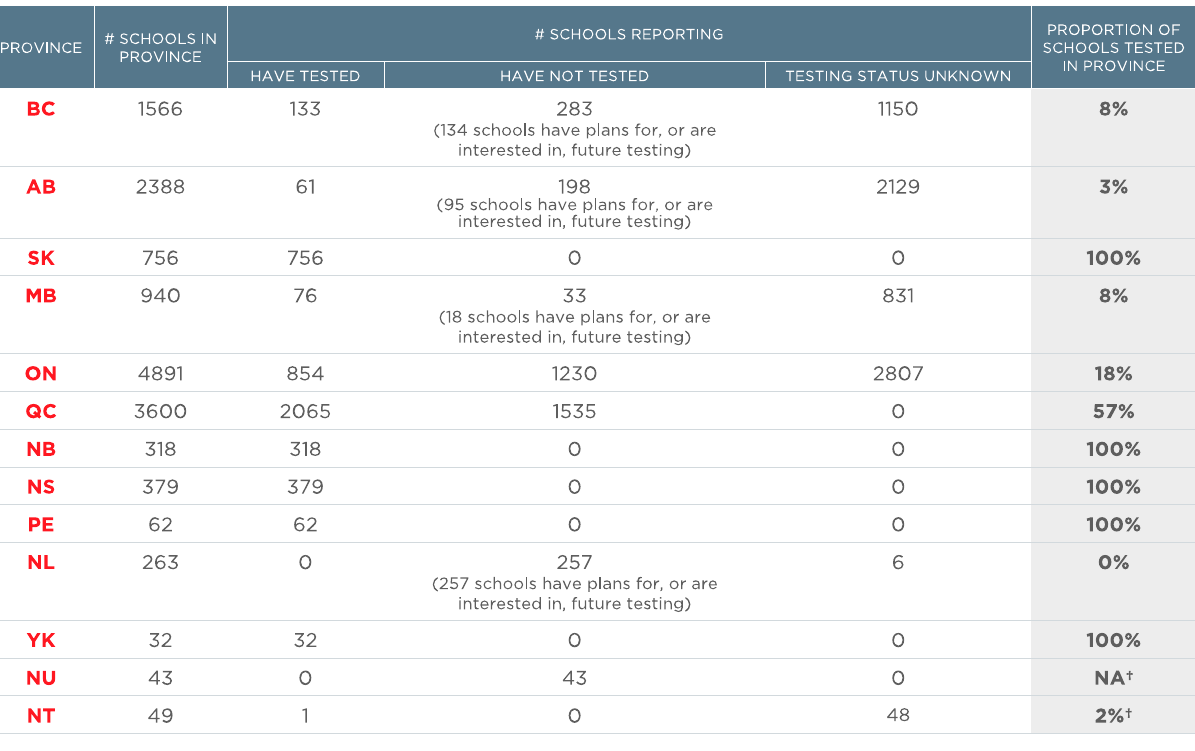
Figure 2. Summary of results by province for Canadian schools reporting radon